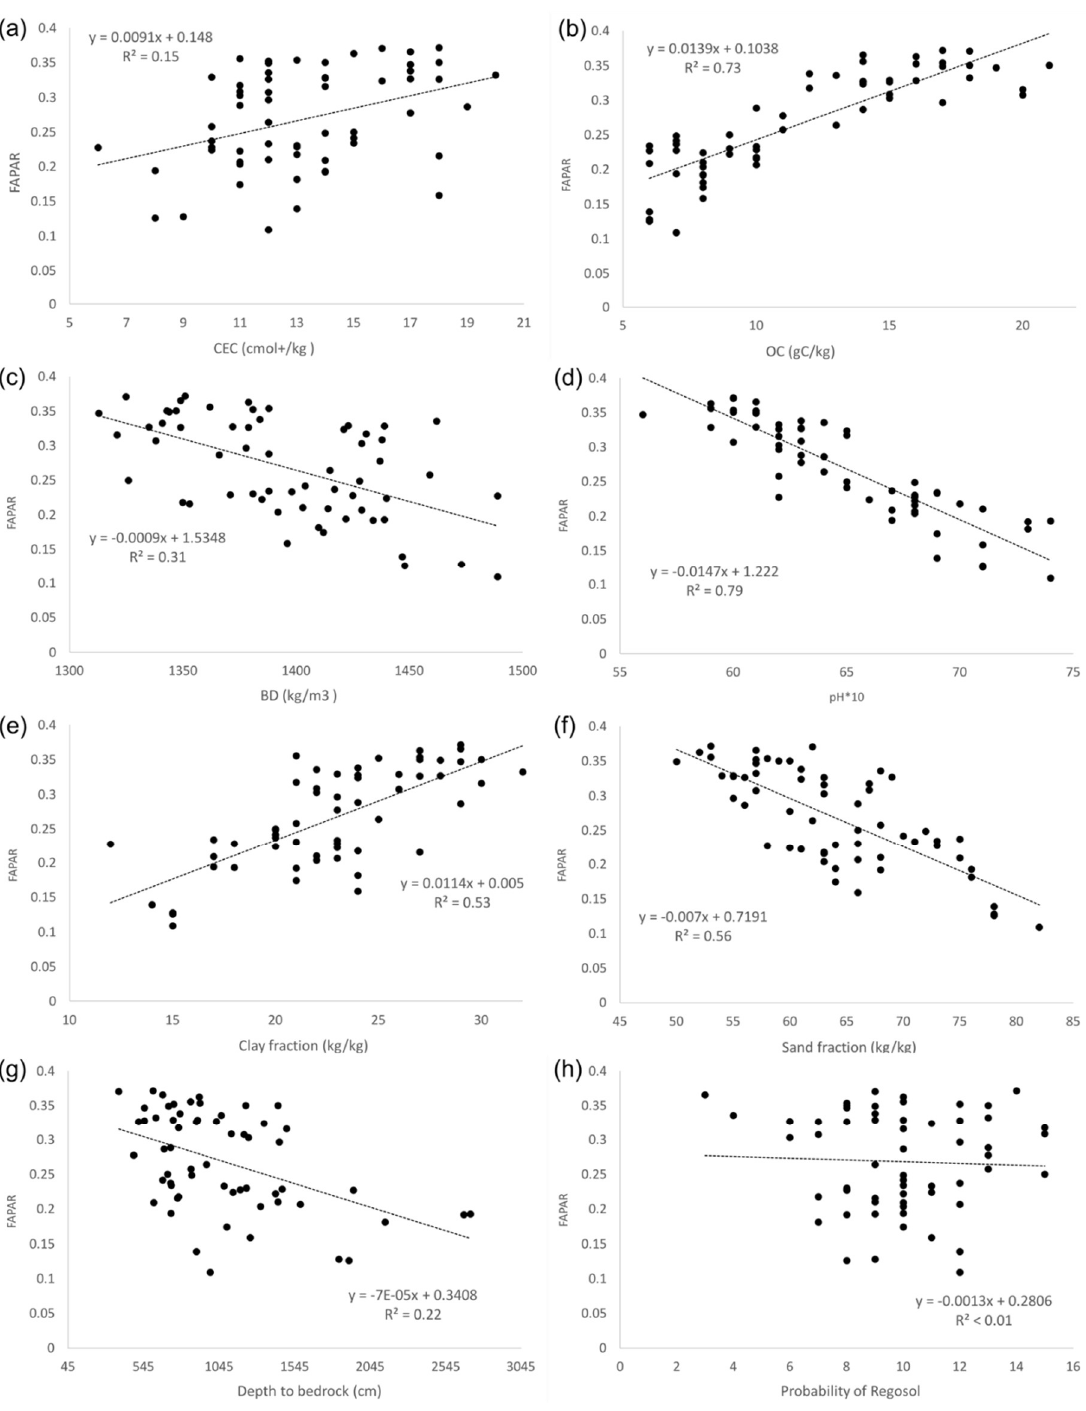
Figure A2. Correlation between the multi-year FAPAR and the various soil variables: ( a ) cation exchange capacity, ( b ) soil organic carbon, ( c ) bulk density, ( d ) pH, ( e ) clay fraction, ( f ) sand fraction, ( g ) depth to bedrock, ( h ) probability of Regosol at each grassland site.